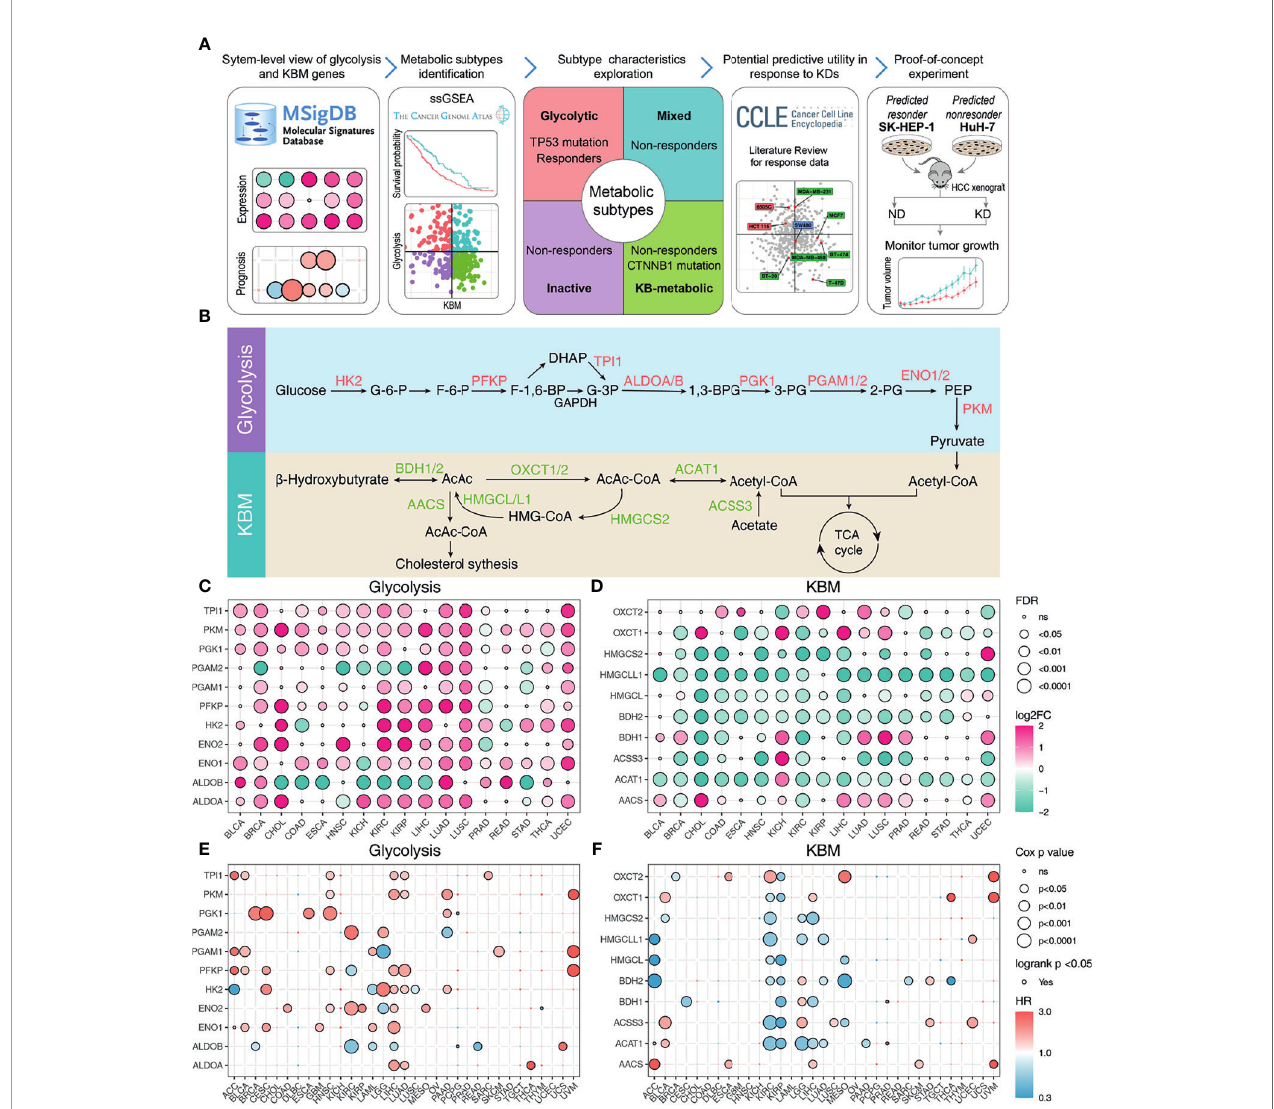
FIGURE 1 | The expression pattern and prognosis of glycolysis and KBM genes in cancer patient samples from TCGA datasets. (A) Overview of the study work fl ow. (B) Schematic model illustrating the glycolysis and KBM pathway. The selected signature genes are marked in the pathway, with glycolytic enzymes in red and ketone bodies metabolic genes in green. The bubble plot shows the expression pattern of glycolysis (C) and KBM (D) genes in non-tumor and tumor tissues across cancer types. Only the cancer types with at least 5 non-tumor tissues were included in this analysis. Red represents upregulation and green represents downregulation. The point size represents fold-change and the shade of color represents p-value. The FDR and fold change were determined by edgeR. The bubble plot shows the result of survival analysis of glycolysis (E) and KBM (F) genes for each cancer type. Both Cox proportional analysis and log-rank test were used to determine the statistical signi fi cance, which was represented by the size and border of circle, respectively. The color of circle represents hazard ratio (HR), in which red indicates high risk for survival and green indicates low risk. The p-value was determined by log-rank test and wald test. ns, not signi fi